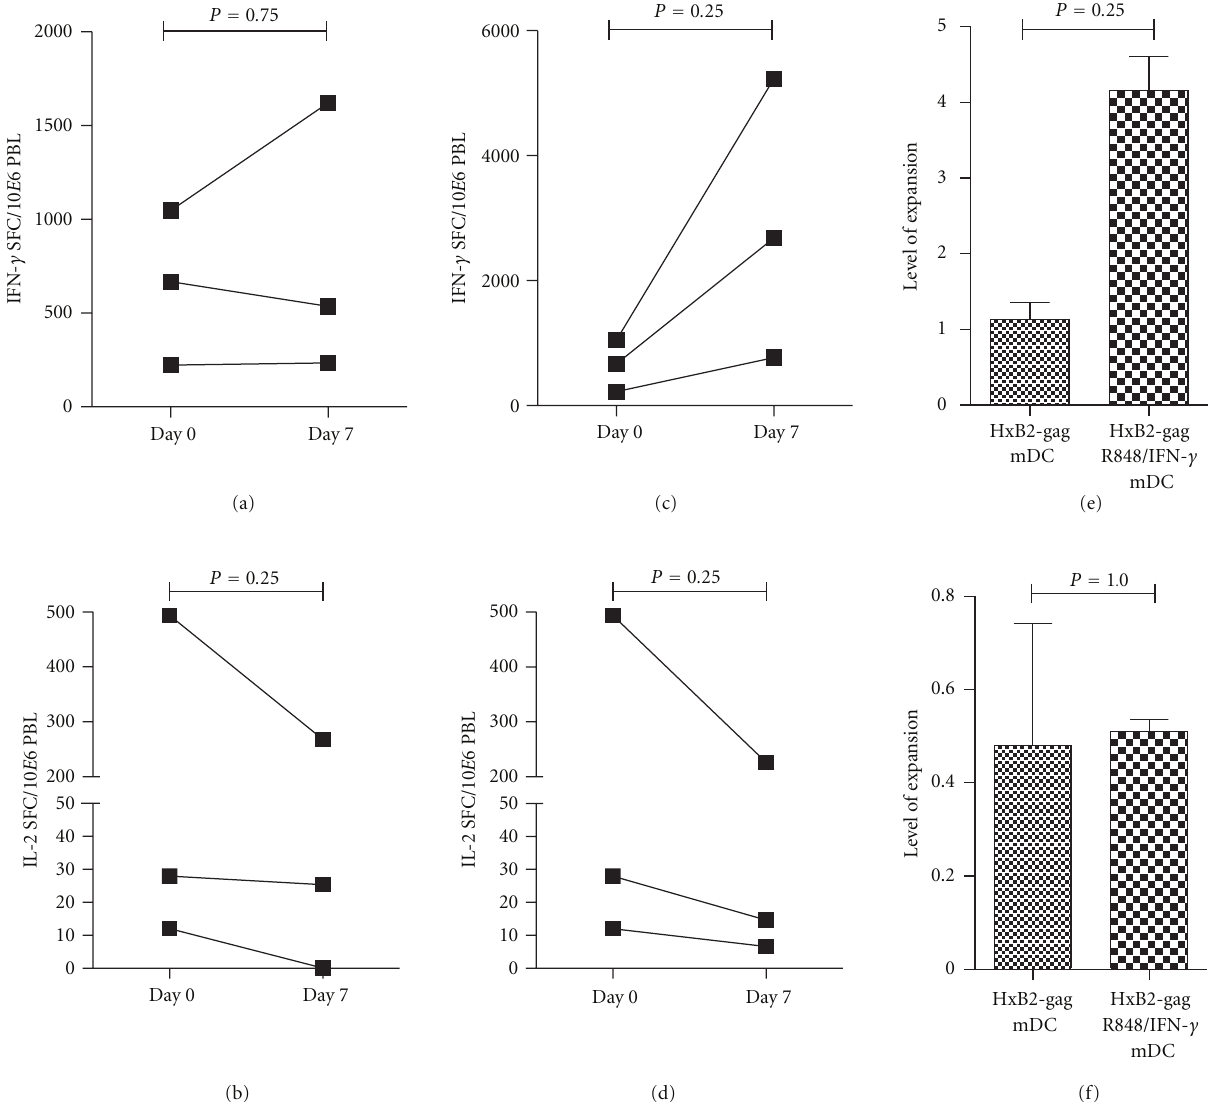
Figure 3: E ff ect of addition of TLR7/8 ligand, R848, and IFN- γ for activation of DCs on HIV gag -specific T cell responses after 1 week of stimulation. Freshly thawed PBLs were directly incubated in ELISpot with HIV gag -derived peptides (Day 0) or PBLs were stimulated for one week with autologous HIV gag mRNA-electroporated DCs. For this, DCs were either matured with a simplified cytokine cocktail (TNF- α and PGE 2 ) (a) and (b) or DCs were matured with a simplified cytokine cocktail in combination with TLR7/8 ligand resiquimod (R848) and IFN- γ (c) and (d). Thereafter, cocultured PBLs were restimulated with HIV gag -derived peptides and evaluated in ELISpot for detection of antigen-specific IFN- γ (a), (c), and (e) or IL-2 (b, d, and f) secretion. Results are shown as mean of triplicate analyses for each donor displaying a positive response ( n = 3), as defined in the Materials and Methods